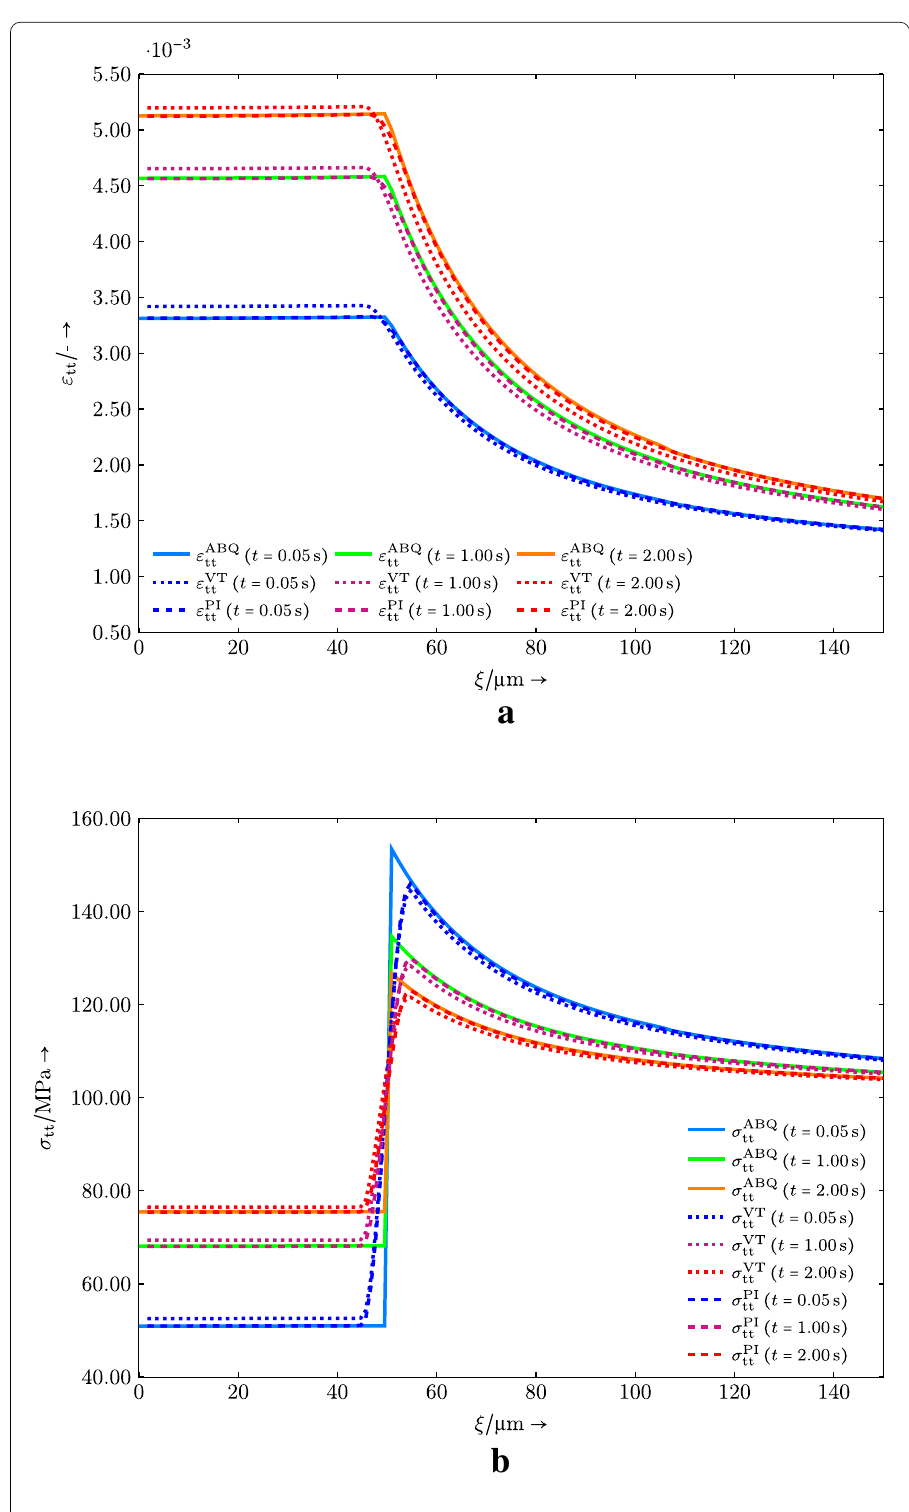
Fig. 12 Results for a ε tt and b σ tt along ξ : Comparison of quantities tangential to the interface of the VT and the PI approach to the sharp-interface solution computed with Abaqus . Three different times ( t = { 0 . 05 , 1 . 00 , 2 . 00 } s) are plotted along